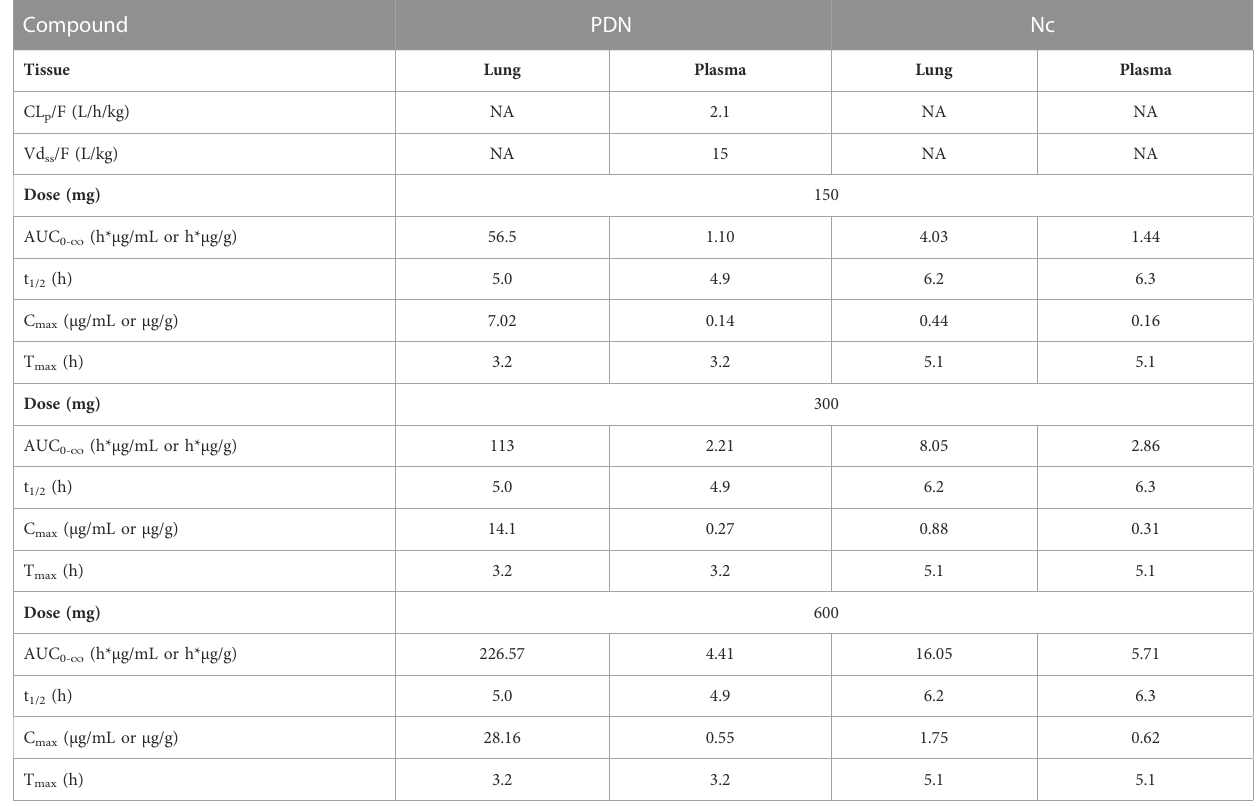
TABLE 8 Simulated pharmacokinetic pro fi les of representative single oral PDN dose at 600, 300, and 150 mg in a 65-kg human